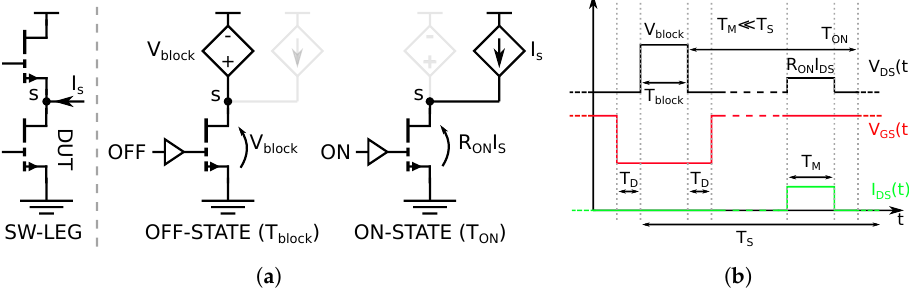
Figure 1. Measurement technique working principle. ( a ) Switching leg states during the dynamic periodic measurement procedure; ( b ) waveforms of the proposed measurement technique.